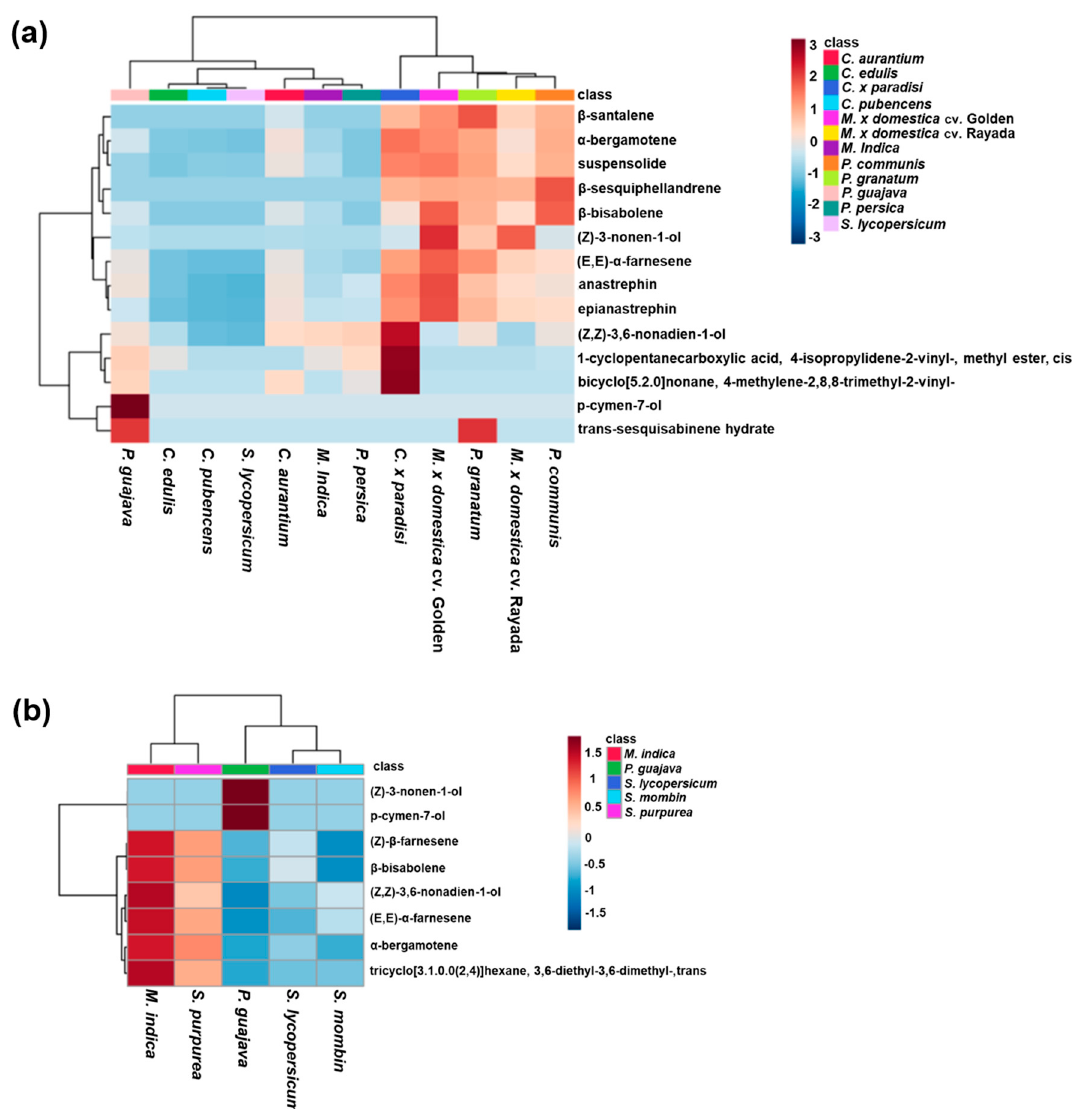
Figure 3. Heatmaps showing the hierarchical clustering of mean abundances in chemical compounds (peak area) related with the volatiles contained in the effluvia (i.e., scent bouquet) released by sexually-mature calling males of two species within the highly derived fraterculus species group: ( a ) A. ludens and ( b ) A. obliqua. Note that the scent bouquet of P. guajava (conditional host) and C. x paradisi (preferred host) are the most contrasting in A. ludens , and, in the case of A . obliqua again, P. guajava , an occasional host, is the most contrasting. “Golden” used as abbreviation for ‘Golden Delicious’ in the case of M. x domestica.